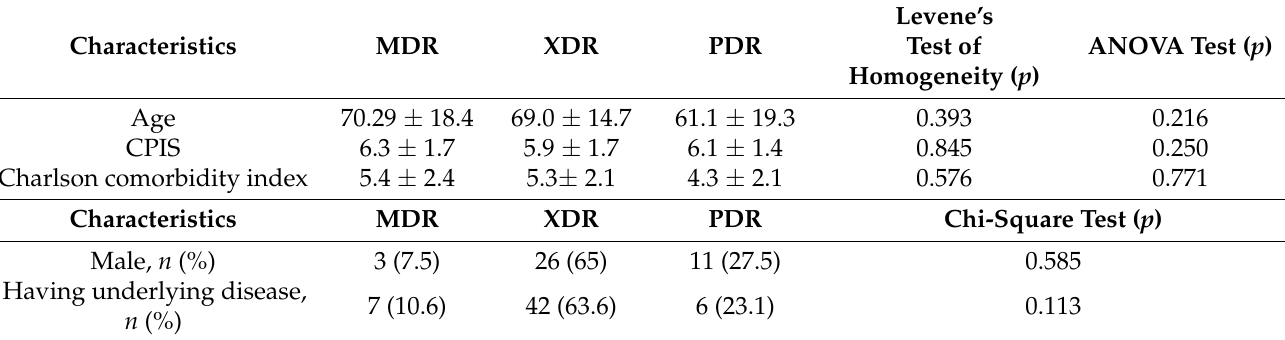
Table 2. General characteristics of the patients in the study stratified by resistance classification.